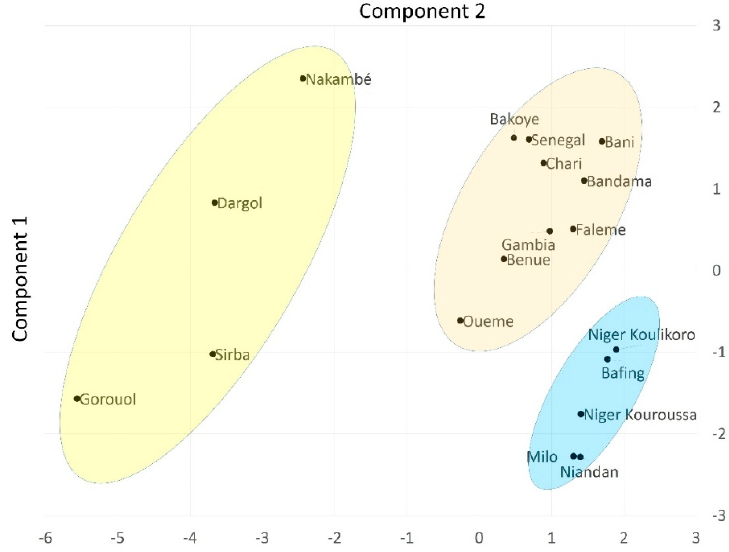
Figure 7. The classification of the main components of the PCA study; the two components concerned explain 65% of the variance.